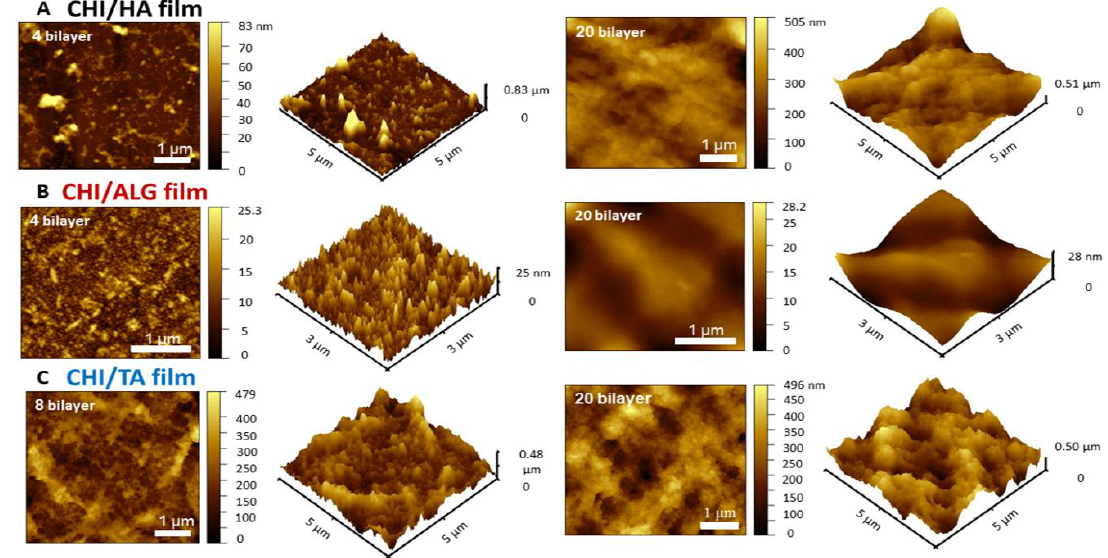
Figure 3. Surface morphology changes in ( A ) CHI / HA, ( B ) CHI / ALG, and ( C ) CHI / TA films as the number of layers increased, as measured by AFM.